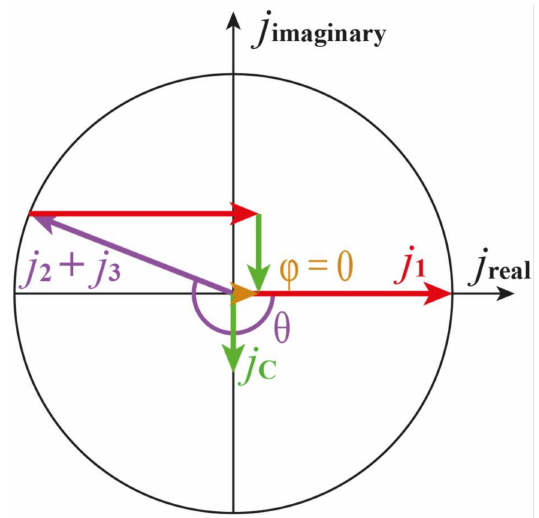
Figure 12. Indication diagram of current density for the case of parallel resonance: j 1 —current density determined by Formula (17), j 2 + j 3 —current density determined by Formula (20), θ = – ωτ —angle between the vectors j 1 and ( j 2 + j 3 ), ϕ = 0 ◦ —phase shift angle determined by Formula